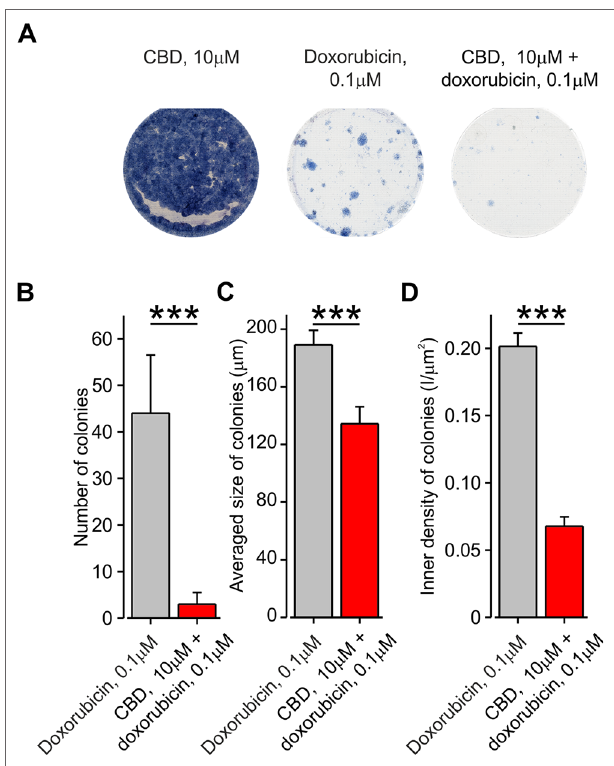
FIGURE 7 | Co-application of doxorubicin with CBD, but not alone, inhibits the formation of BNL1 ME cell colonies. (A) A collage image of BNL1 ME cell colonies 24 h after treatment with 10 μM CBD alone ( left ), 0.1 μM doxorubicin ( middle ), and 10 μM CBD with 0.1 μM doxorubicin ( right ). (B – D) Bar graphs plotting the number of colonies (B) , averaged size of colonies (C) , and inner density of colonies (D) treated with either 0.1 μM doxorubicin ( gray ) or 10 μM CBD with 0.1 μM doxorubicin ( red ). ***—p < 0.001, Student’s t-test, n = 6 colonies for each